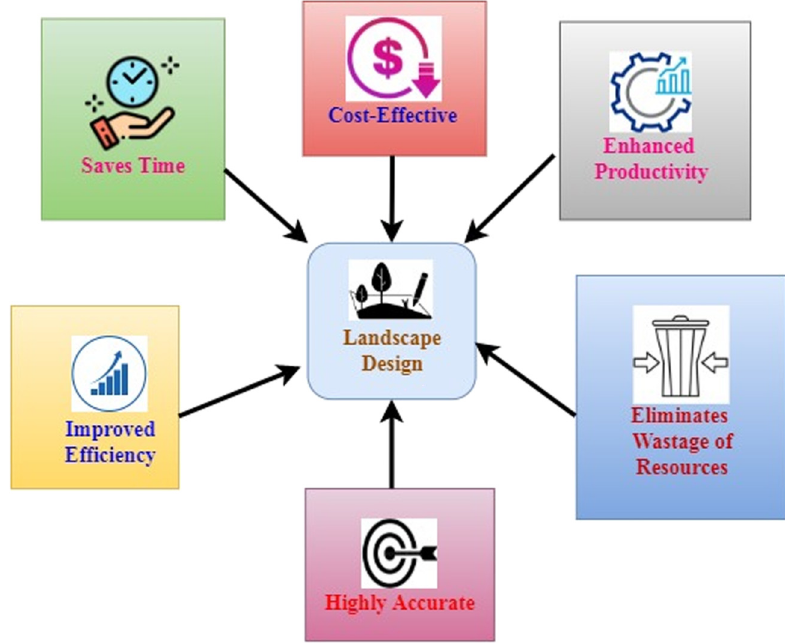
Figure 4: Landscape